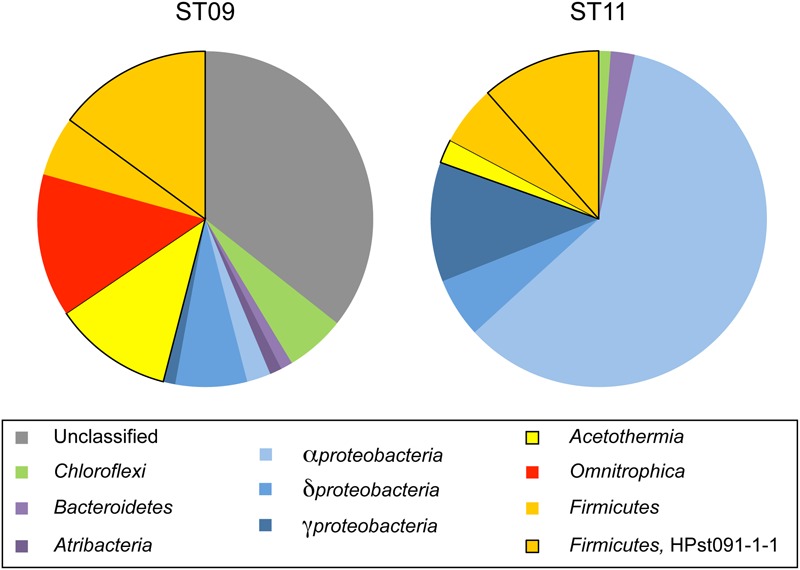
Pie charts showing the relative proportions of phylum-level affiliated sequences retrieved in juvenile chimneys from sites ST09 and ST11 (bulk chimney samples). The dominance of Alphaproteobacteria in site ST11 attested for highest seawater contamination compared to ST09 chimney whose members are dominated by representatives of deep serpentinisation environments (Figure 7). OTU KM207235 HPst091-1-1 represented in both case the major Firmicutes species (i.e., 67 and 72% of this phylum sequences for ST11 and ST09, respectively). Taxonomic affiliations were obtained by comparing partial 16S rRNA gene sequences with sequences of the GenBank database using BLAST (Altschul et al., 1997). The closest environmental sequence and cultivated species are detailed in Figure 7 for site ST09 and in Supplementary Table S3 for site ST11.